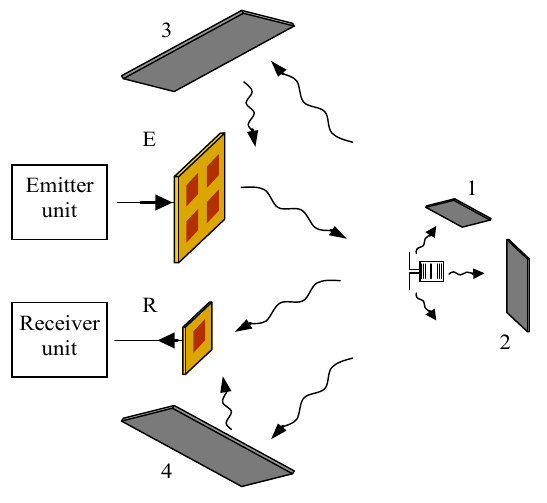
Figure 4. Position of the parasitic reflectors around setup.